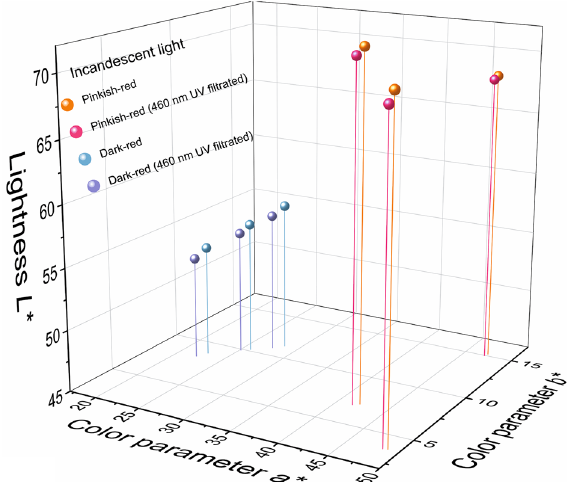
Figure 6. The spinel colors are filtrated by 420 nm in incandescent